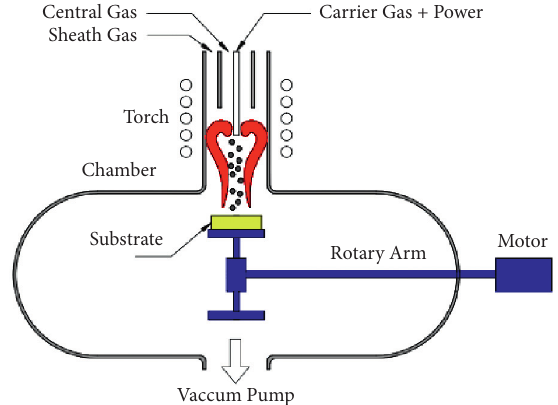
Figure 6: Schematic diagram of RF low-pressure plasma spray